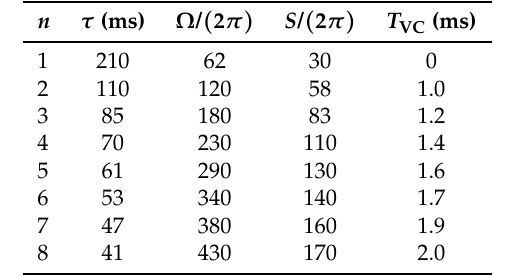
Table 1. Properties of vibrational transitions v = 0 → v (cid:48) = n . T VC is the simulated optimal cooling time for vibrational cooling. Ω / ( 2 π ) and S / ( 2 π ) are in units of